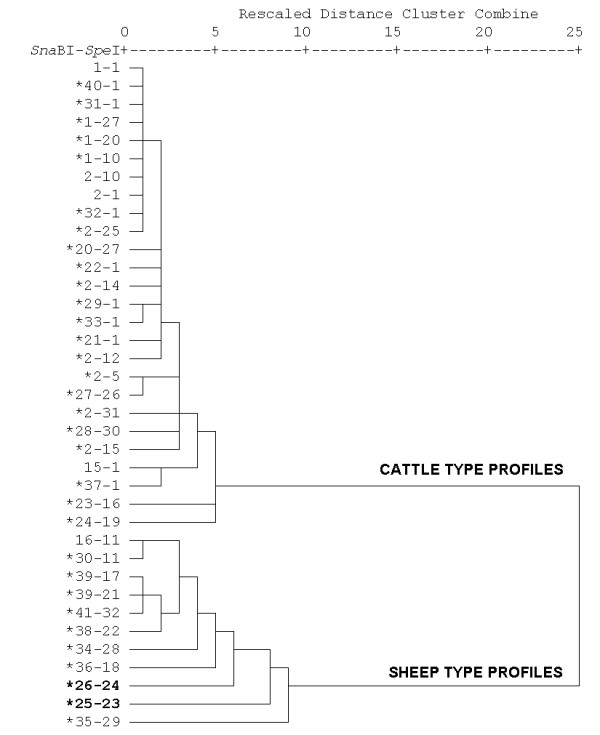
Dendrogram showing the similarities between multiplex PFGE profiles of isolates in the collection studied. The agglomerative hierarchical cluster analysis of the data using the unweighted pair group method with arithmetic averages divided strain profiles in two main branches, cattle type profiles and sheep type profiles. Profiles in boldface correspond to pigmented isolates. *novel profiles found in this study.